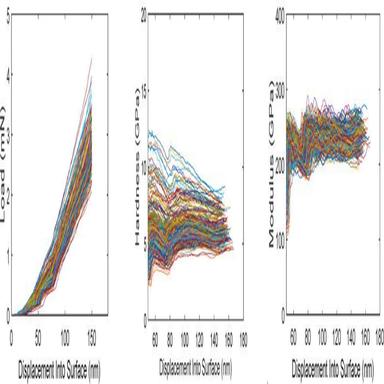
Load vs. Displacement Into Surface, Hardness vs. Displacement Into Surface, Modulus vs. Displacement Into Surface curves (from left to right) from CSM measurements.